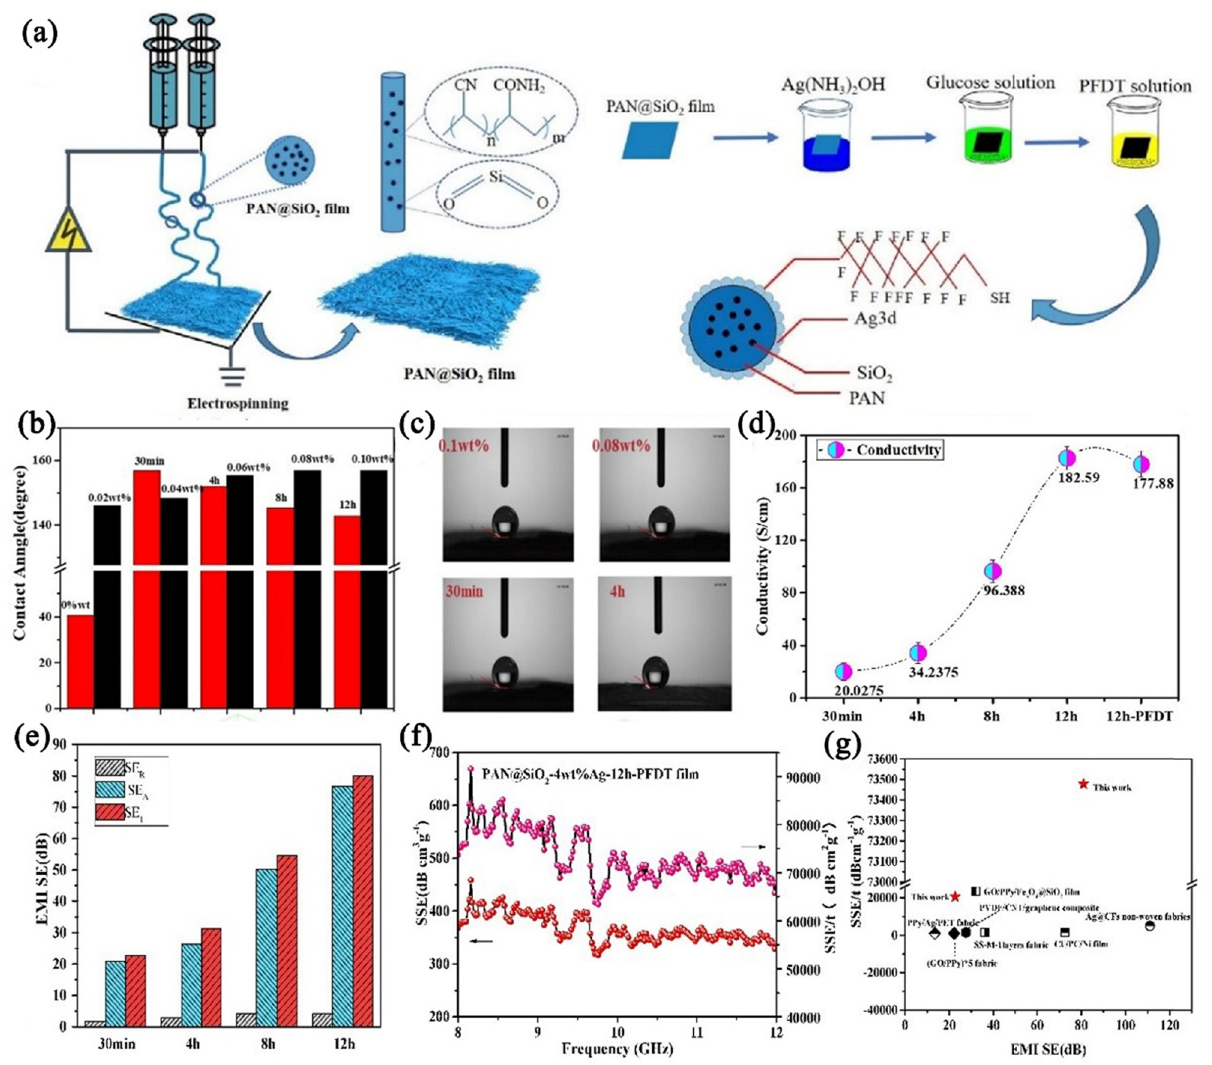
Figure 23: ( a ) Schematic diagram of the preparation of PAN@SiO 2 - 4 wt% Ag - X - PFDT composite fi lm, ( b and c ) PFDT concentration and immersion time on the contact angle ( CAs ) of PAN@SiO 2 - 4 wt% Ag fi lm, ( d ) PAN@SiO 2 - 4 wt% Ag fi lm conductivity of SiO 2 - 4 wt% Ag - X composite fi lm, ( e ) SE A , SE R , and SE T of PAN@SiO 2 - 4 wt% Ag - X fi lm, SE A , SE R , and SE T represent absorption, re fl ection, and total EMI shielding values, ( f and g ) comparison of EMI SE and SSE of various composite fabrics [ 148 ] ; Copyright: 2020 with permission from Elsevier Science